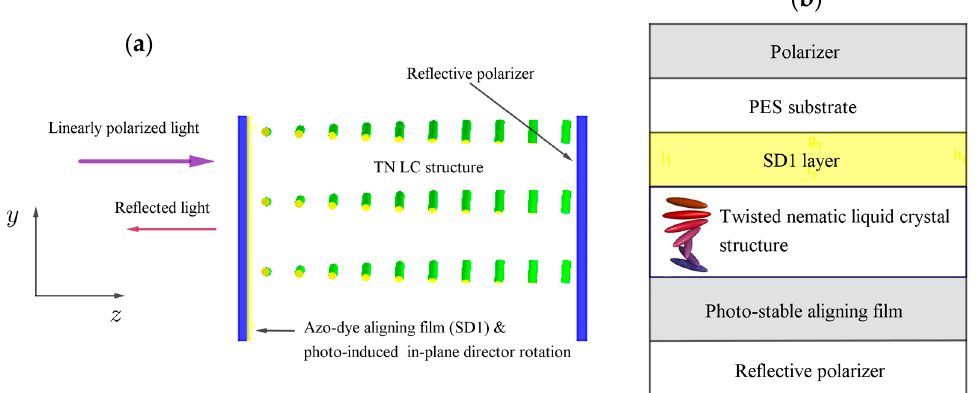
Figure 5. (Color online) ( a ) Schematic representation of twisted nematic liquid crystal cell ( d = 6.85 µ m). ( b ) Device structure of optically rewritable electronic paper (ORW e-paper) [43].